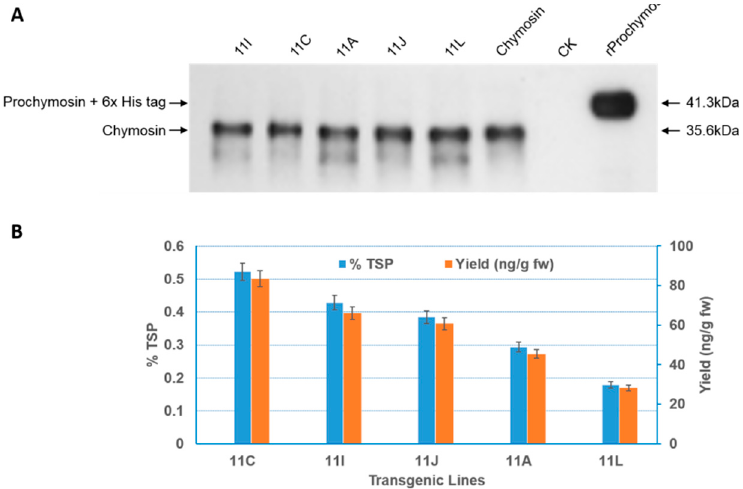
Figure 3. Expression of recombinant bovine chymosin in transgenic tobacco plants. ( A ) Immunoblotting analysis; ( B ) Yield of recombinant bovine chymosin in transgenic plants. Chymosin, CK, and rProchymosin represent commercial chymosin isolated from calf, crude TSP from wild-type plant and recombinant prochymosin with 6× His tag from E. coli respectively; 11A, 11C, 11I, 11J, and 11L represent different individual transgenic plant lines or crude TSP from them. Yield data are collected from three independent duplicates for each line.